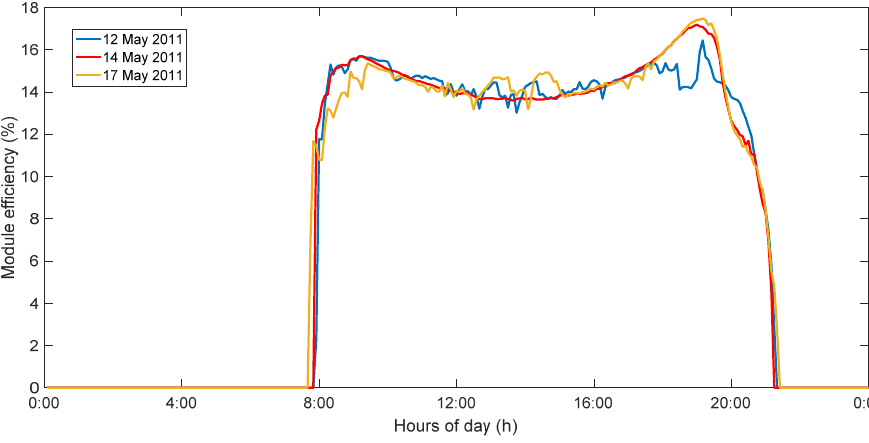
Figure 20. Daily profiles of module efficiency obtained during 12, 14 and 17 May 2011.